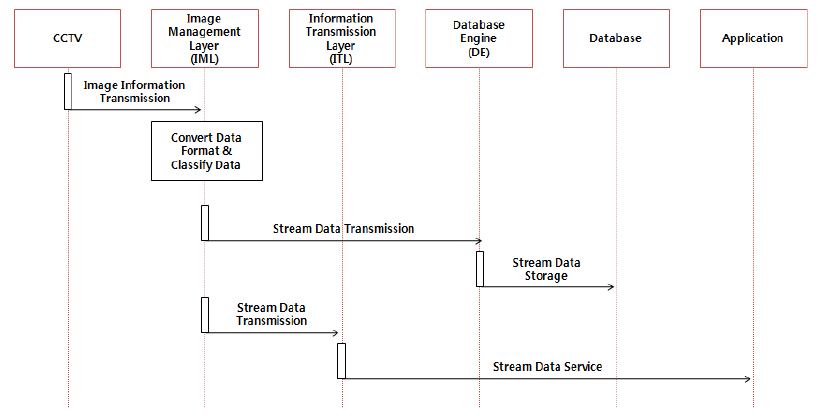
Figure 4. Operation Process of Hog Farm Image Monitoring